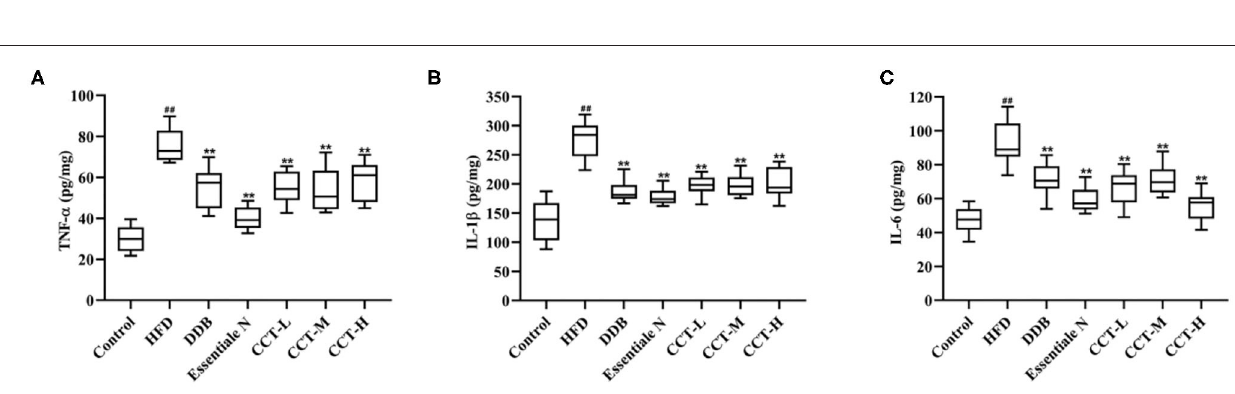
FIGURE 9 | Effects of CCT on inflammation biomarkers. (A) Effects of CCT on TNF- α . (B) Effects of CCT on IL-1 β . (C) Effects of CCT on IL-6. ## P < 0.01 vs. Control group; ** P < 0.01 vs. HFD group.